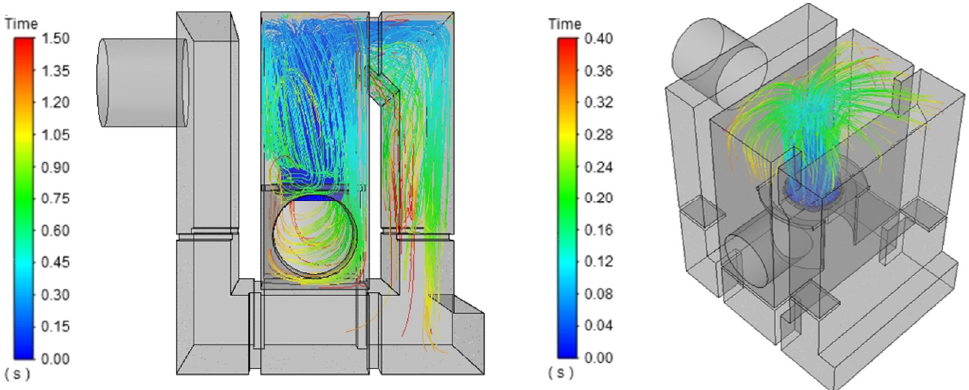
Figure 10. Tracks of gas particles escaping from the burner—time scale (s).